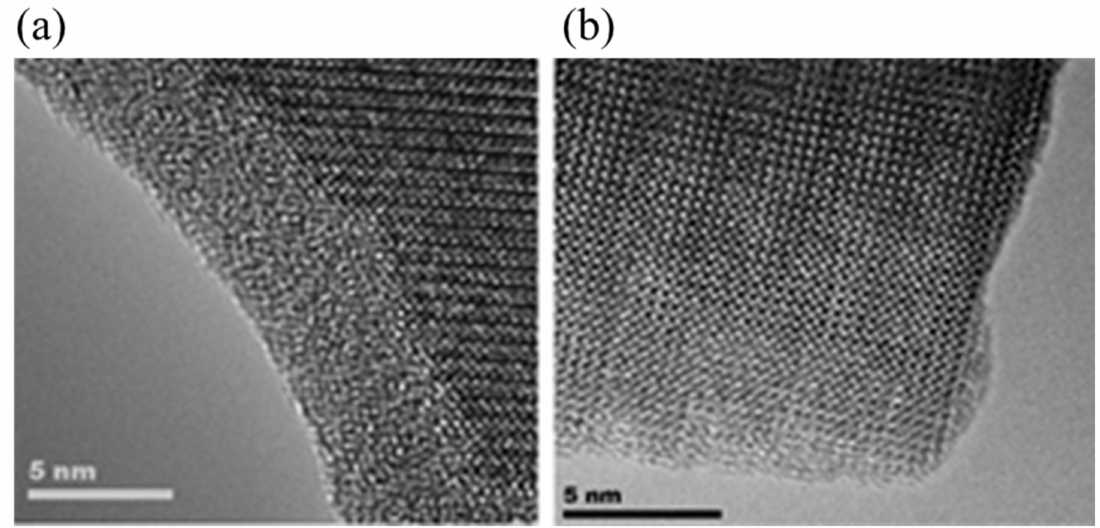
Figure 13. ( a ) Schematic of ultramicrotome and ( b ) images illustrating the ultramicrotome cross-sectioning and slices (the cutting direction is parallel to the desired surface and the slice is with nanoscale thickness and wide dimension) [132]. Figure 13a reprinted from Journal of Power Sources, High-resolution chemical analysis on cycled LiFePO 4 battery electrodes using energy-filtered transmission electron microscopy, Joshua D.Sugar, Farid El Gabaly, William C. Chueh, Kyle R. Fenton, Tolek Tyliszczak, Paul G. Kotula, Norman C. Bartelt, 246, 512–521, with permission from Elsevier (2013). Figure 13b reprinted from [130] Methods in Cell Biology, 152, Valentina Baena, Richard Lee Schalek, Jeff William Lichtman, Mark Terasaki, Serial-section electron microscopy using automated tape-collecting ultramicrotome (ATUM), 41–67, Copyright (2019), with permission from Elsevier.